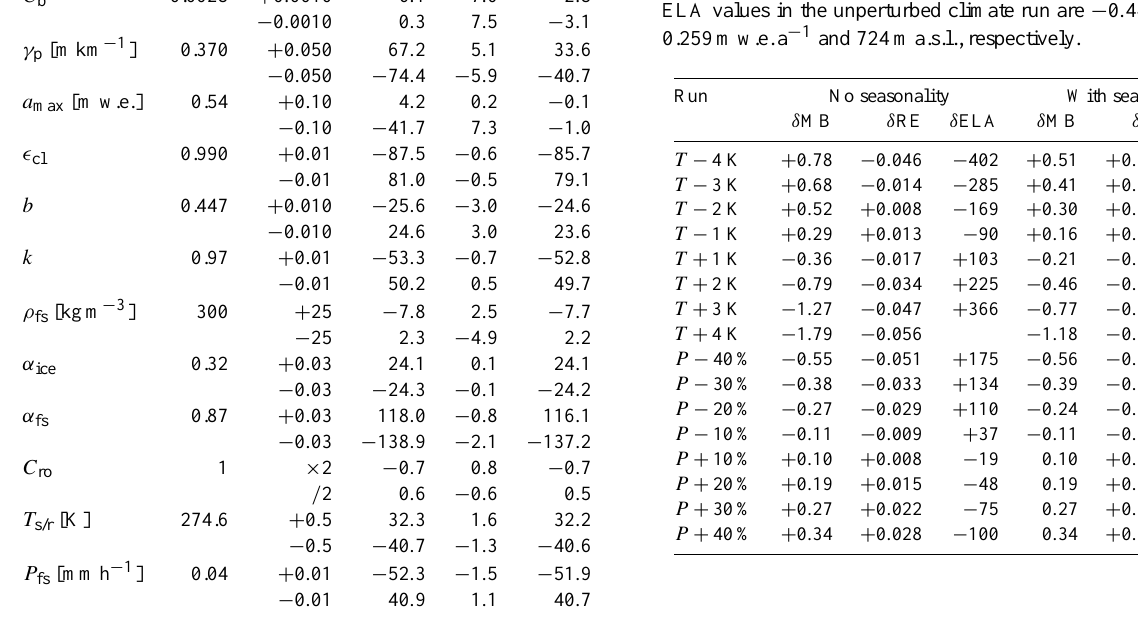
Table 2. Overview of the mass balance sensitivity ( δ MB), re- freezing sensitivity ( δ RE) and ELA sensitivity ( δ ELA) to changes in air temperature T and precipitation P . Sensitivities are given in mw.e.a − 1 for the mass balance and refreezing sensitivity and ma.s.l. for the ELA sensitivity. The non-seasonal δ ELA in the run with T + 4 K could not be resolved since the ELA in this scenario is above the highest point on the grid. Mass balance, refreezing and ELA values in the unperturbed climate run are − 0 . 448mw.e.a − 1 ,